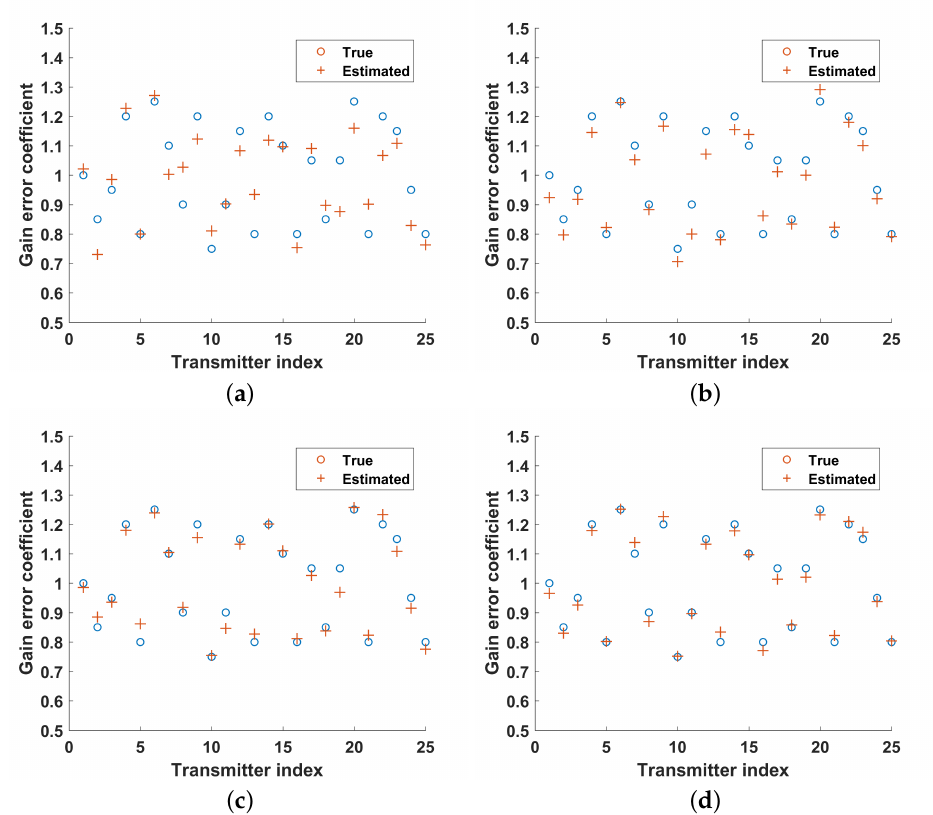
Figure 5. Gain error estimation under different number of strips ( a ) no strip; ( b ) two strips; ( c ) four strips; ( d ) eight